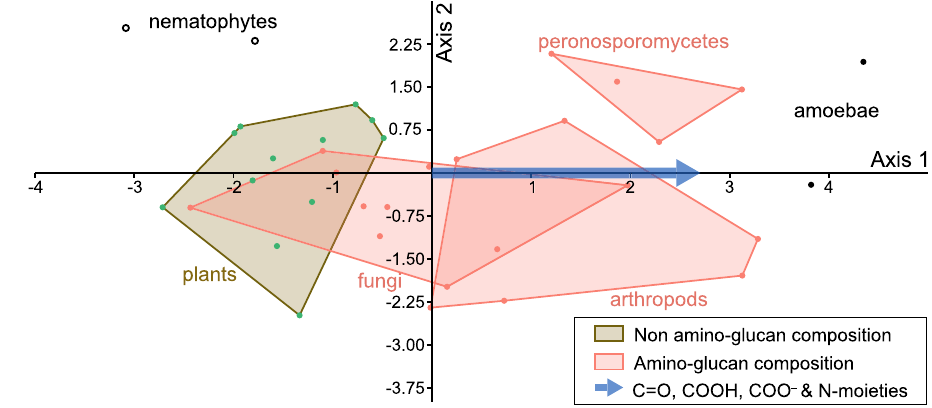
Fig. 3 | Canonical Correspondence Analysis of Rhynie chert fossils. Specimens are distributed according to the organic bands relative to fossilization products of sugars and protein (carbonyl, carboxyl, and N-moieties), showing rightward an